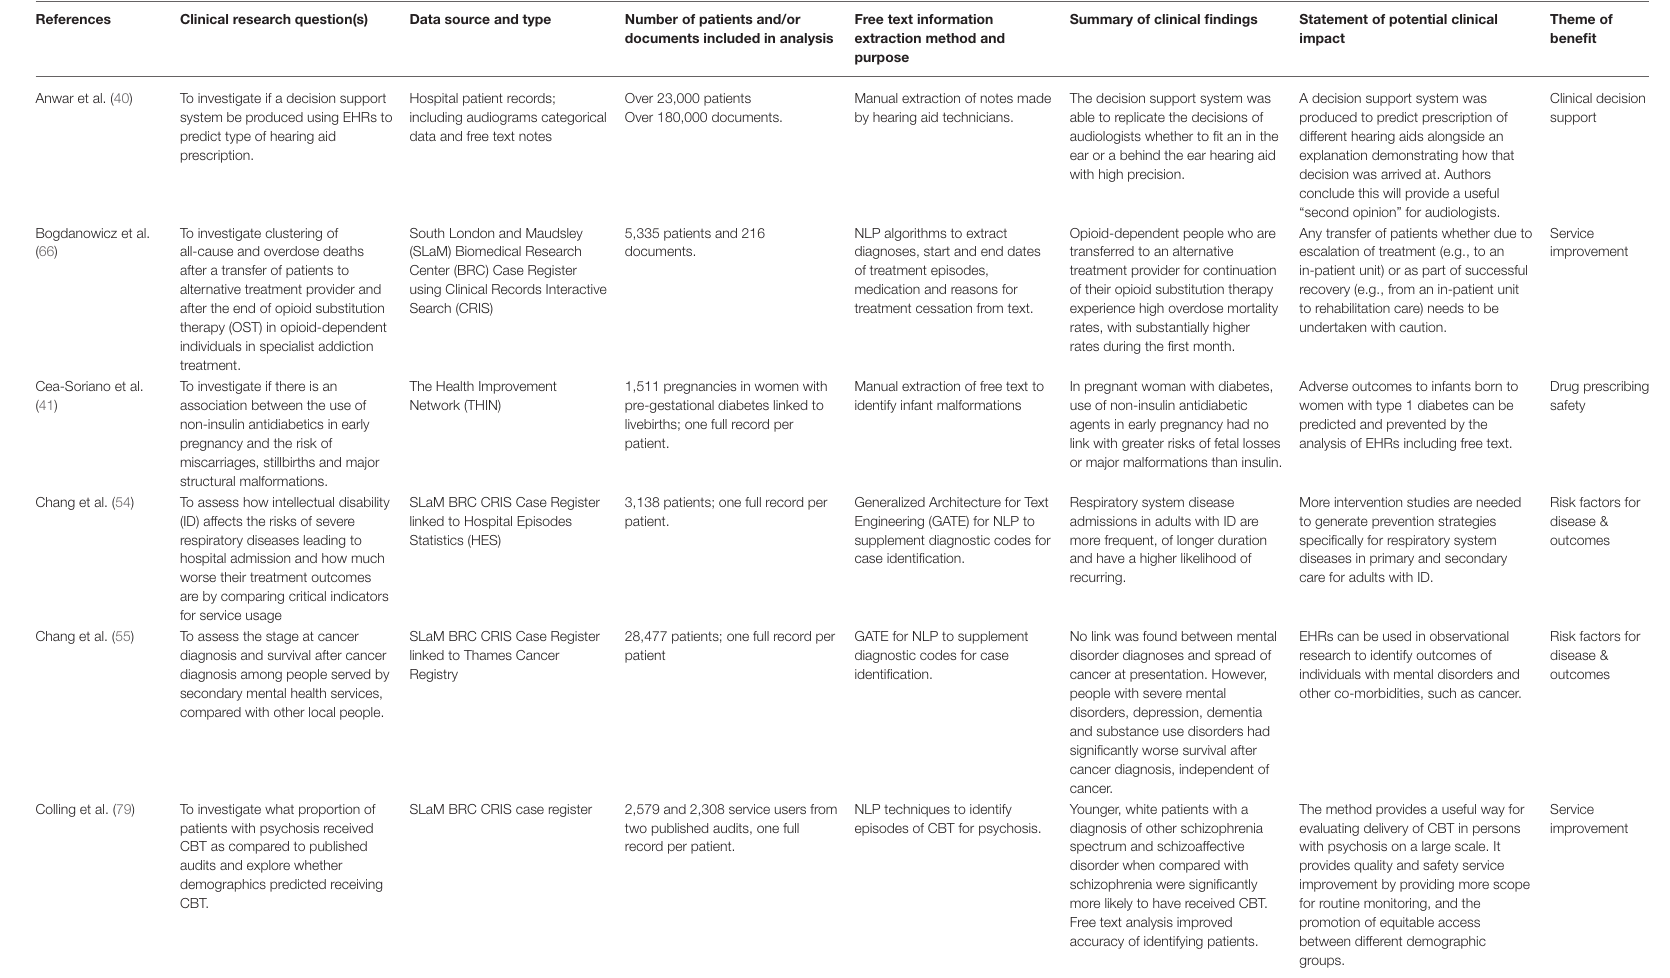
TABLE A1 | Overview of included